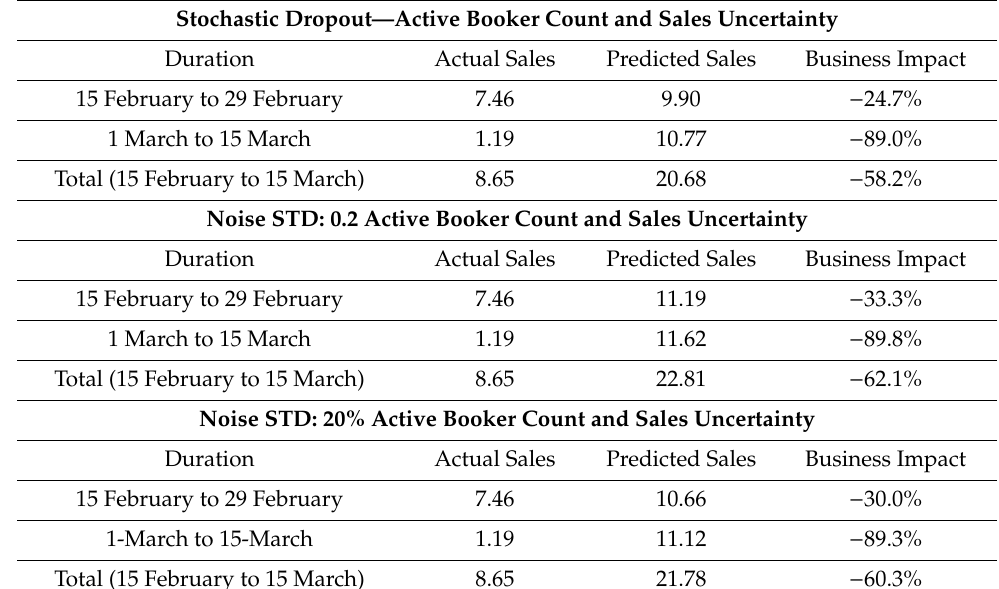
Table 2. Impact of corona virus on sales.